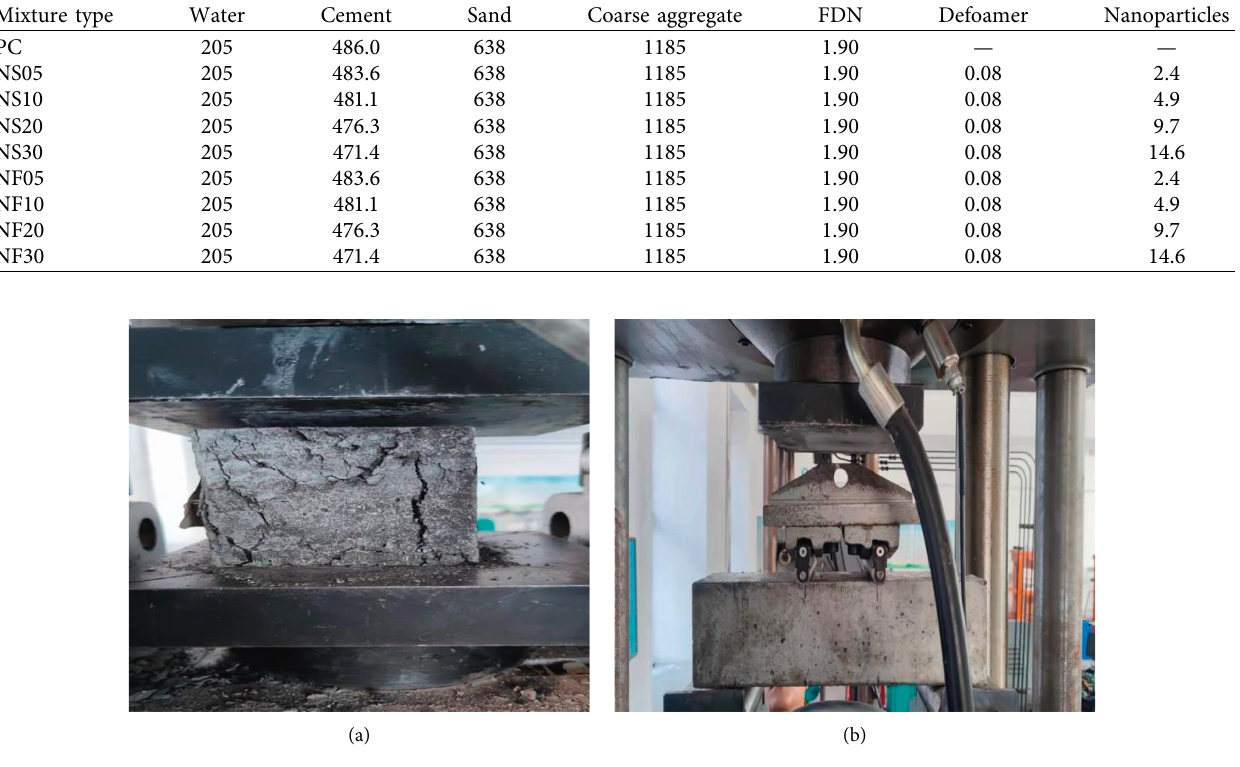
Figure 1: (a) Compressive strength tests. (b) Flexural strength tests.